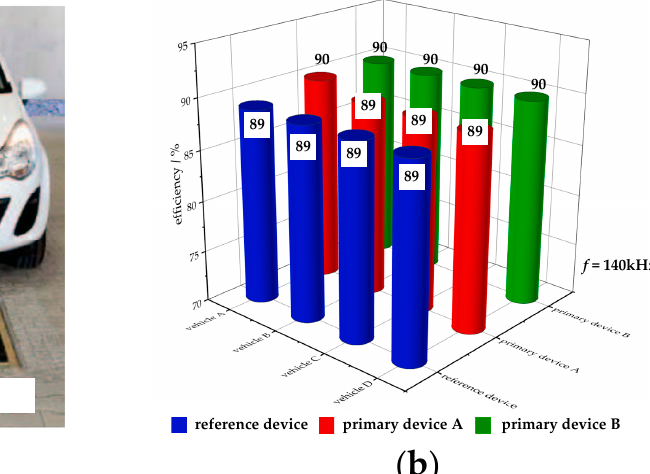
VA and GA; ( b ) Efficiency test results.